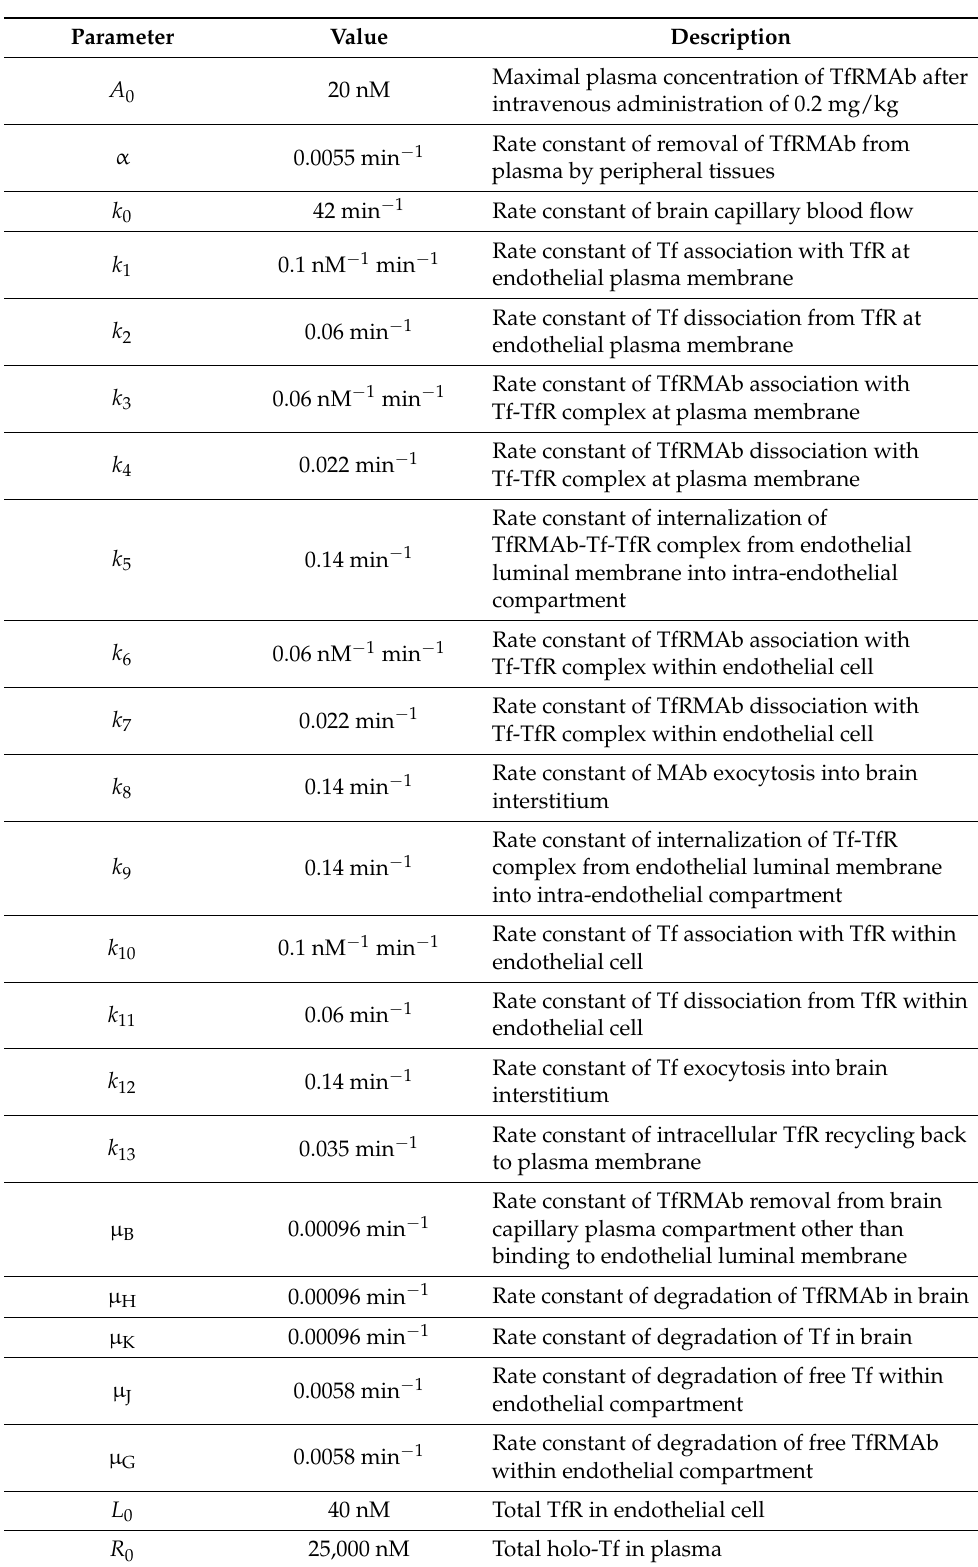
Table 2. Parameter definitions and starting values for TfR